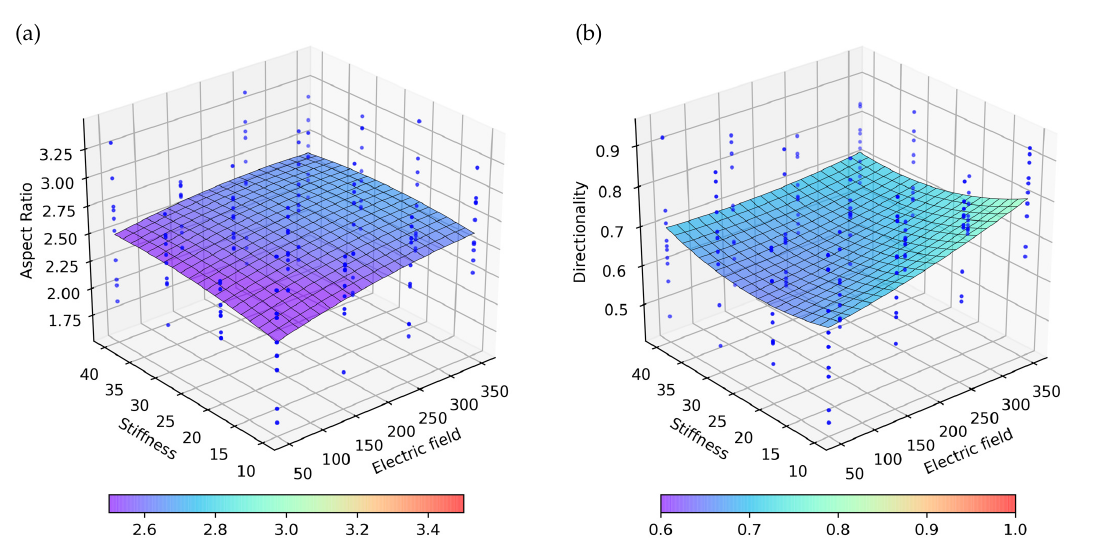
Figure 9. Representation of the obtained numerical results applying a pulsatory electric field with different intensities in ECM with different stiffnesses. Blue dots represent 10 experiment repetitions, on which the surface with the best fit to the results is represented. ( a ) Aspect ratio for the different combination of stiffness and electric stimulus. ( b ) Directionality for the different combination of stiffness and electric